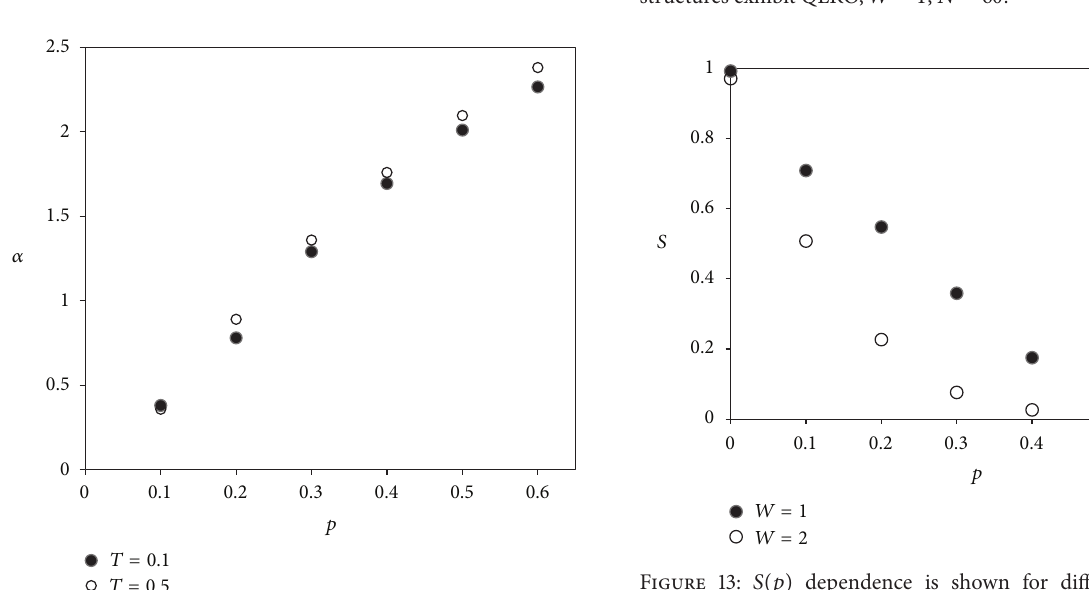
Figure 12: Behavior of 𝛼 on varying 𝑇 . Homogeneous history . The structures exhibit QLRO, 𝑊 = 1 , 𝑁 = 60 .